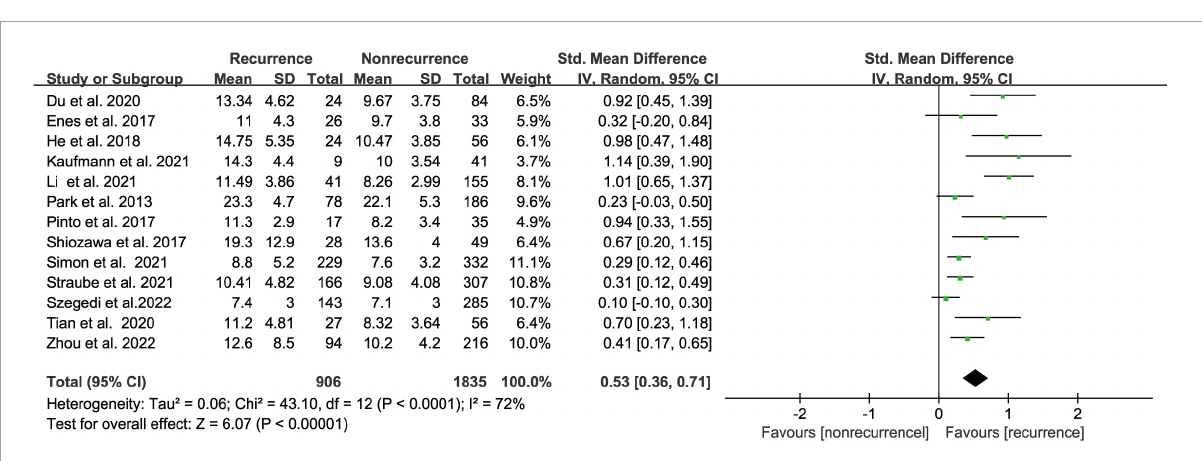
FIGURE3 Forest plot showing the difference in LAA volume between patients with and without AF recurrence after catheter